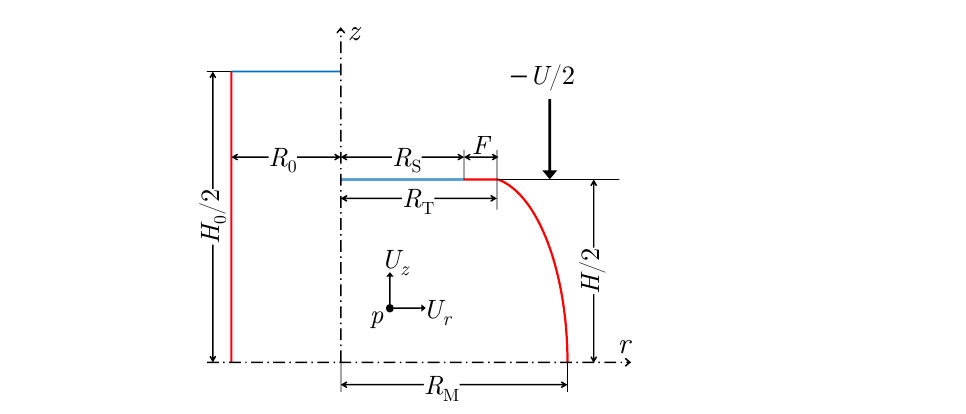
Figure 1. The schematic of the sample geometry in axisymmetric compression test (left) before and (right) after the deformation. R 0 and H 0 are the sample’s initial radius and height, respectively. By deforming the sample with a constant velocity of − U /2 parallel to the z axis, three characteristic radii can be identified: the mid-plane ( R M ), top-plane ( R T ) and slip ( R S ) radii with foldover being F = R T − R S . ( R S is the result of the expansion of R 0 , and F is the contribution of the side surface foldover, resulting in a larger top-plane radius R T ). In a flow-based model, any point p ( r , z ) moves based on the radial and axial components of the velocity field ( U r , U z